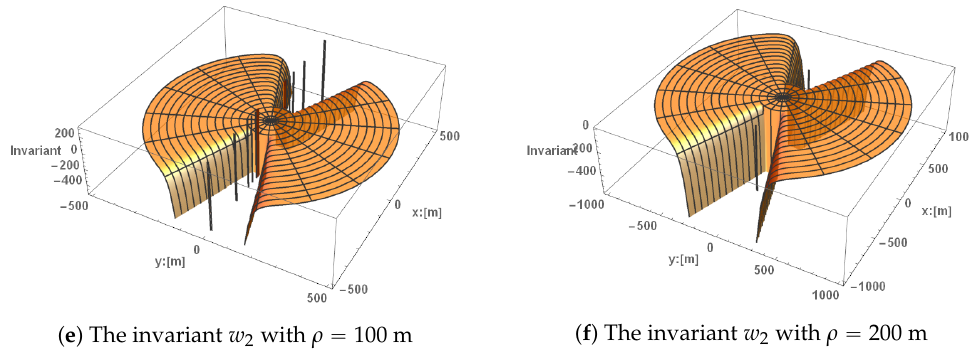
Figure A8. The warp bubble radius, ρ , of the invariants r 1 , r 2 , and w 2 are plotted in the figures above. The other parameters were set to be σ “ 50,000 m ´ 1 , a “ 1.0 m s ´ 2 , and t “ 1 s. The plots were rendered using Mathematica’s ® RevolutionPlot3D. It plots a function by rotating the function around the z-axis. The amount that the space diverges from being flat is represented by the invariant function’s magnitude, and its amount is labeled on the vertical axis. The x and y-axis are displayed on the plots, and they display the distance from a spaceship in the flat portion at the center of each figure. Each radial line in the left hand column corresponds to a distance of approximately 33 m and each radial line in the right hand column corresponds to a distance of approximately 67 m. The constant portion to the right of the harbor is to the front of the warp bubble, and the constant portion to the left of the harbor is the back of the warp